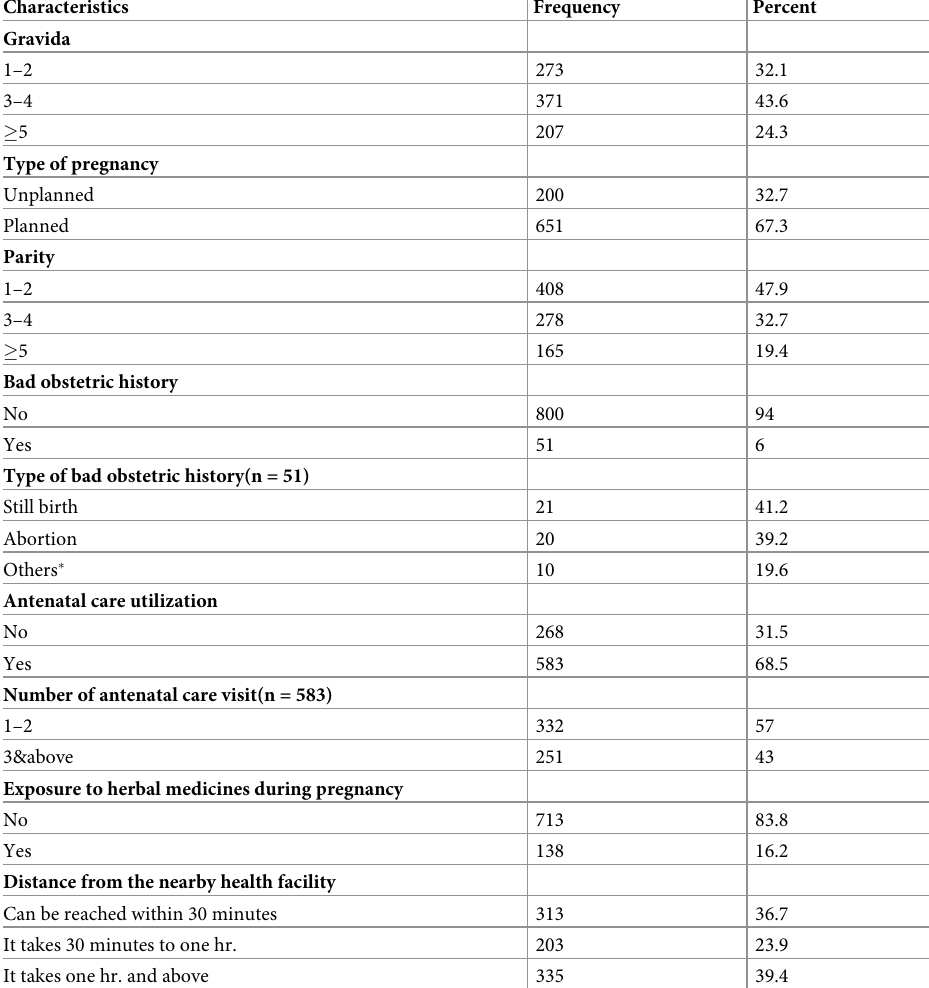
Table 2. Obstetrical and maternal health care service related characteristics of respondents in Motta town and Hulet Eji Enese district, northwest Ethiopia, 2021.